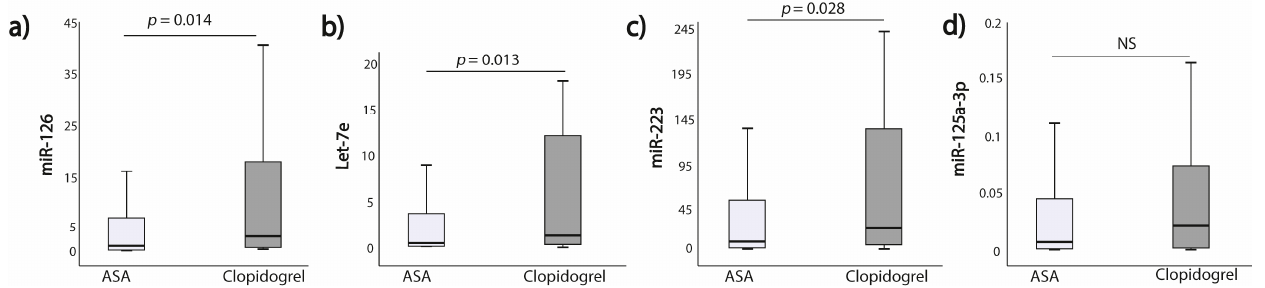
Figure 3. MiRNAs expressions in regard to the type of antiplatelet treatment based on randomization (ASA 75 mg vs. ASA 150 mg vs. Clopidogrel); ( a ) miR-126; ( b ) Let-7e; ( c ) miR-223; ( d ) miR-125a-3p.